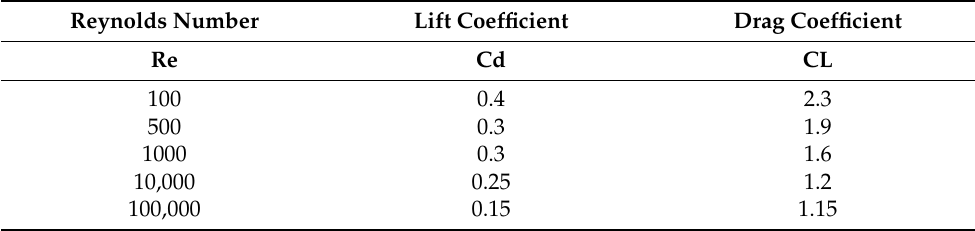
Table 3. Results for G/D =